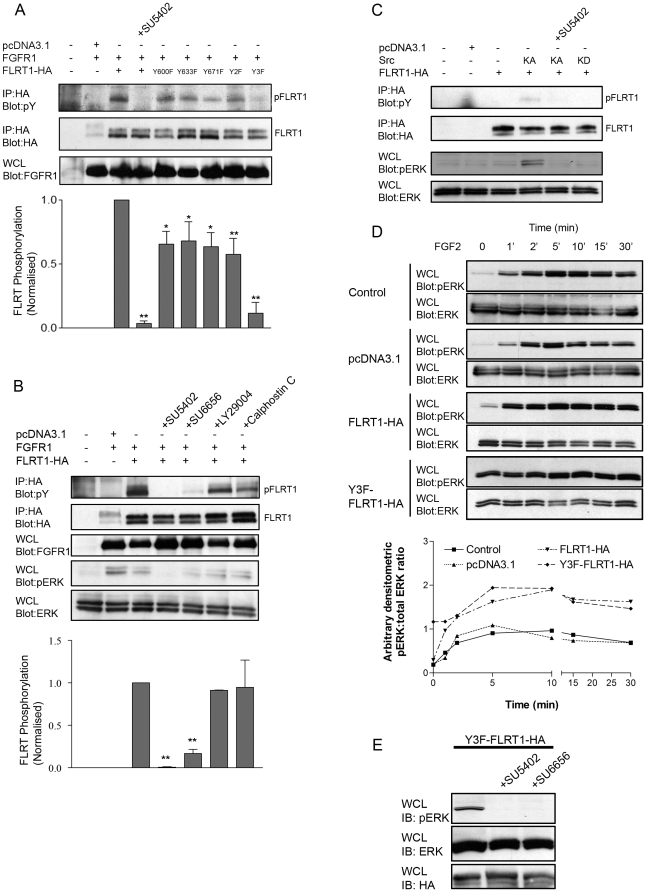
FLRT1 is not a SFK substrate but phosphorylation is FGFR-and SFK-dependent.A) HEK 293T cells were transfected with control (pcDNA31) or FGFR1 and a panel of either full-length FLRT1-HA or tyrosine substitution contructs as indicated (see Materials & Methods) One sample was pre-treated with FGFR kinase inhibitor (SU5402, 50mM, 1 hr) where indicated Cell lysates were immunoprecipitated with anti-HA and subsequently blotted with anti-phosphotyrosine (IP: HA, Blot: pY) or anti-HA (IP: HA, Blot: HA) to examine phosphorylated FLRT1HA levels (pFLRT1) or total immunoprecipitated FLRT1-HA levels (FLRT1), respectively Whole cell lysate (WCL) fractions were probed with anti-FGFR1 (Blot: FGFR) to control for protein expression B) HEK 293T cells were transfected with pcDNA31, FGFR1 and FLRT1-HA as indicated Cells were pre-incubated (1hr) with pharmacological inhibitors (SU5402, 50mM; SU6656, 20mM) Cell lysates were immunoprecipitated with anti-HA and subsequently blotted with anti-phosphotyrosine (IP: HA, Blot: pY) for pFLRT1 and anti-HA (IP: HA, Blot: HA) for FLRT1 WCL fractions were probed with anti-FGFR1 (Blot: FGFR), anti-phospho-ERK (Blot: pERK) or anti-ERK (Blot: ERK) Data in A) and B) are representative of ≥3 independent experiments Densitometric analysis (mean ± sem, n = 3) is the ratio of pFLRT1:FLRT1 and normalised to FLRT1 phosphorylation in the absence of inhibitor in both cases (**p<001, *p<005 non-parametric one way ANOVA) C) HEK 293T cells were transfected with pcDNA31, FLRT1-HA alone or co-transfected with either a constitutively active (KA) or kinase dead (KD) c-Src construct Cells were serum starved for 1hr and cell lysates immunoprecipitated with anti-HA and subsequently blotted with anti-phosphotyrosine (IP: HA, Blot: pY) for pFLRT1 or anti-HA (IP: HA, Blot: HA) for FLRT1 WCL fractions were probed with anti-phospho-ERK (Blot: pERK) or anti-ERK (Blot: ERK) Data are representative of 3 independent experiments D) HEK 293T cells were transfected with either pcDNA31 vector, FLRT1-HA or Y3F-FLRT1-HA constructs Cells were co-stimulated with FGF2 (20ng/ml) and heparin (10mg/ml) for the indicated times Cell lysates were blotted for anti-phospho-ERK (WCL IB: pERK), membranes were stripped and re-probed for anti-ERK (WCL IB: ERK) Densitometric analysis has been adjusted for ERK loading and expressed as an arbitrary pERK:ERK ratio Data are representative of at least 4 independent experiments E) 293T cells transfected with Y3F-FLRT1-HA were serum-starved in the absence or presence of pharmacological inhibitors of FGFR1 (SU5402, 50mM) and SFKs (SU6656, 20mM) and whole cell lysates probed with antiphospho-ERK (IB: pERK), anti-ERK (IB: ERK) and anti-HA (Blot: HA) for Y3FFLRT1-HA.